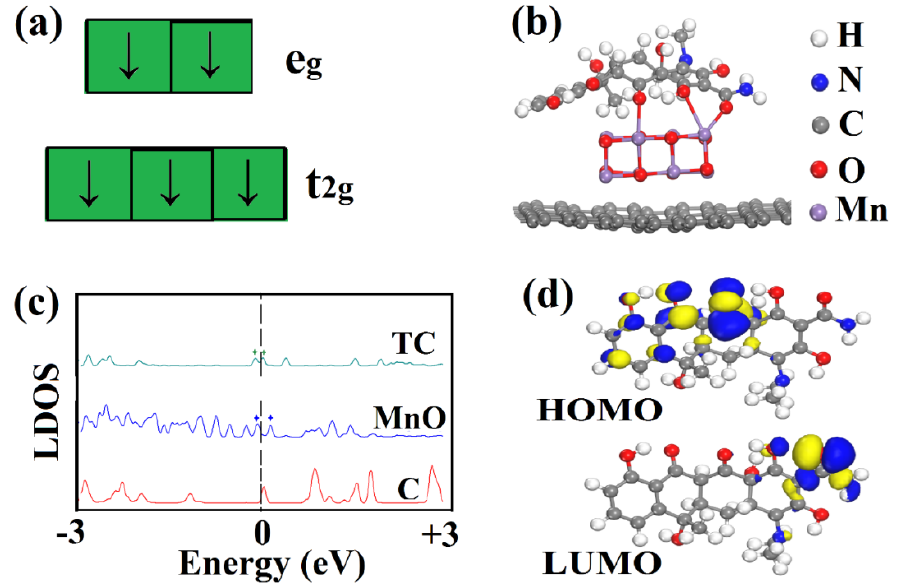
Figure 9. Theoretical calculations. Schematic 3d-orbitals splitting under the octahedral field ( a ); optimized TC / MnO / graphene structure ( b ); calculated local density of states ( c ); and calculated frontier orbitals of TC ( d ).